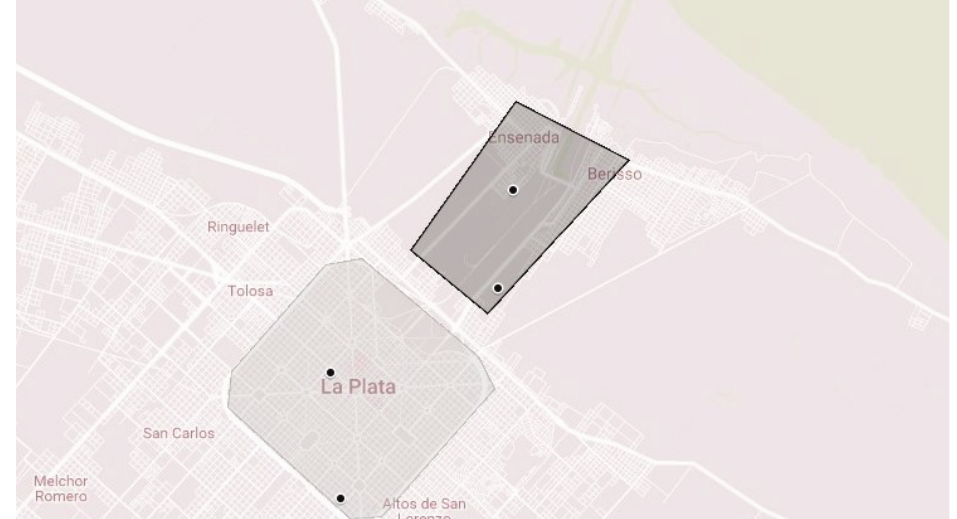
Figure 1. Map of the cities of La Plata, Berisso, and Ensenada, depicting both study areas –industrial zone (dark gray box) and urban zone (light gray box) – and monitoring points (black circles), obtained from Google My